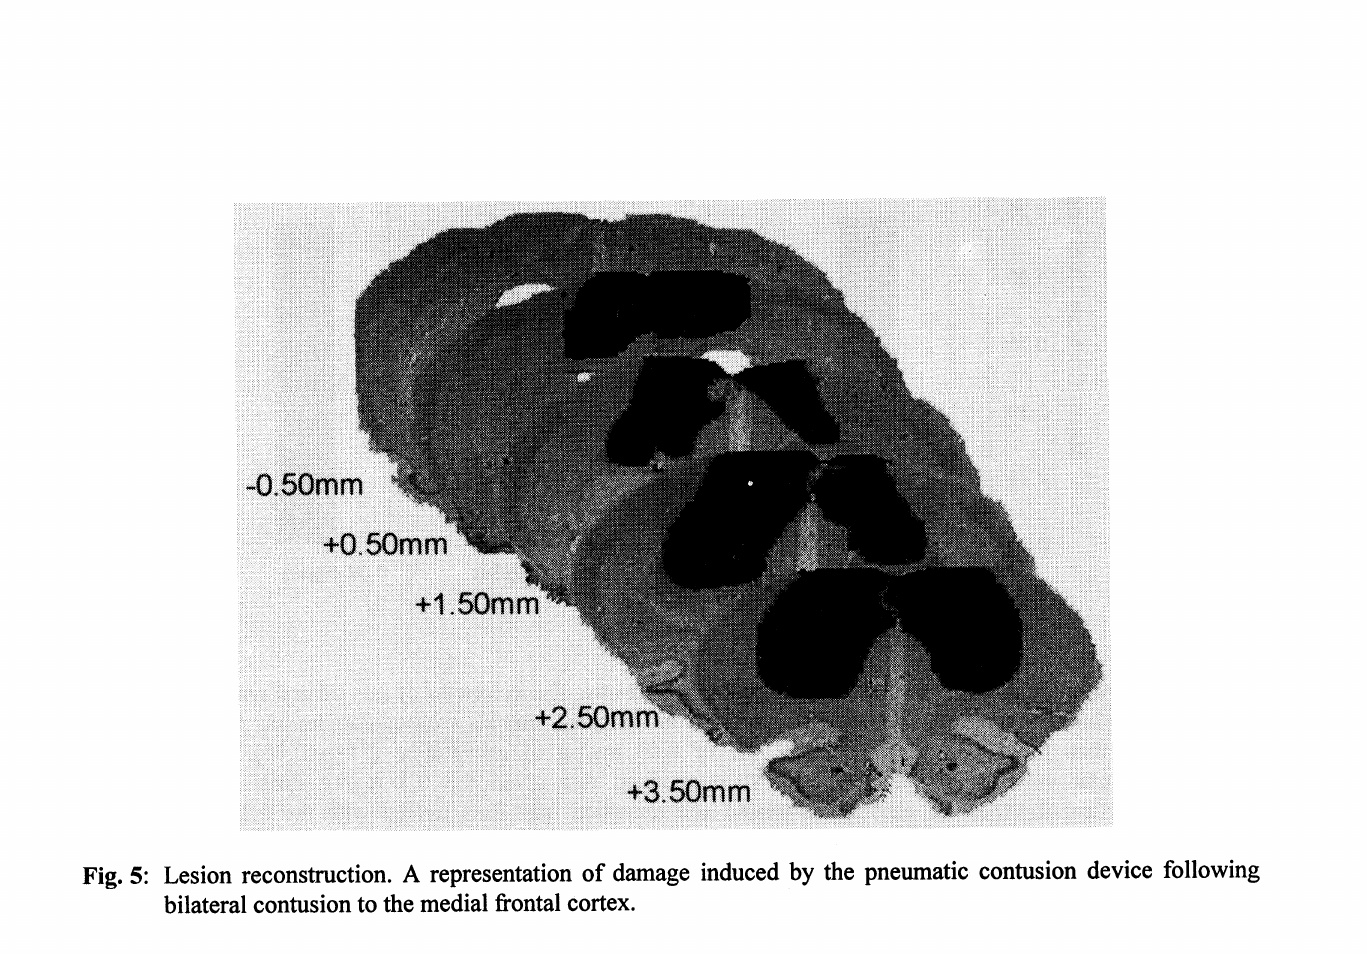
Fig. 5: Lesion reconstruction. A representation of damage induced by the pneumatic contusion device following bilateral contusion to the medial frontal